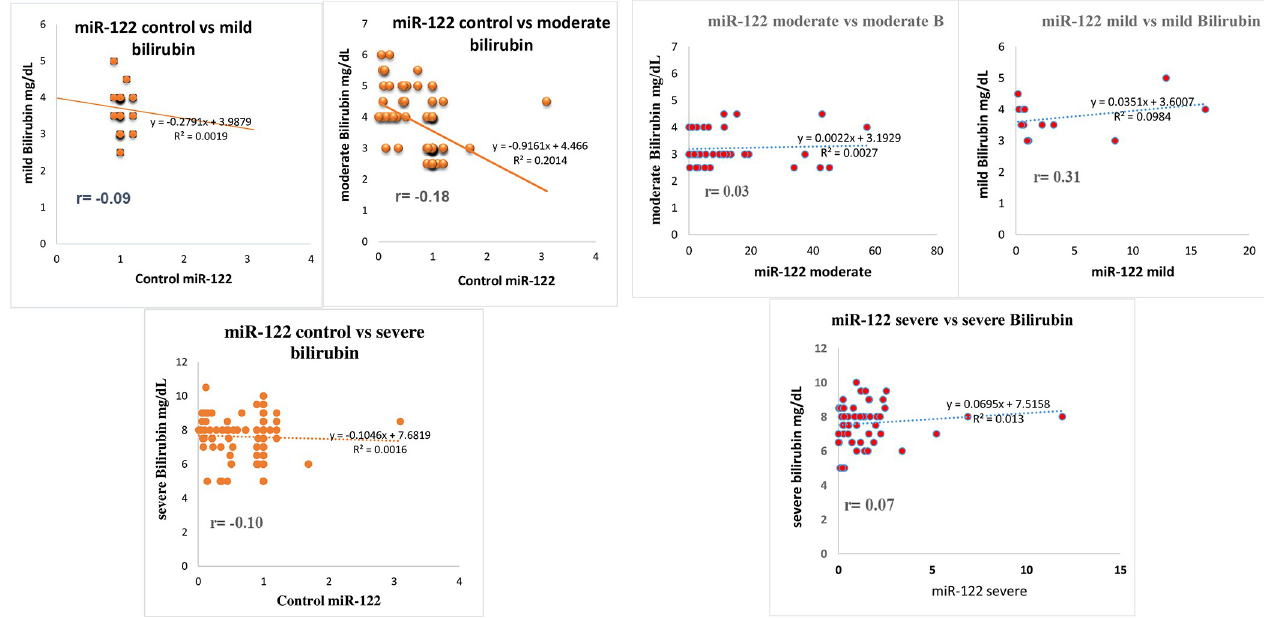
Fig 10. A: Correlation of bilirubin group with healthy control of miR-122. B: Correlation of bilirubin group with miR-122 HCV cirrhotic groups.